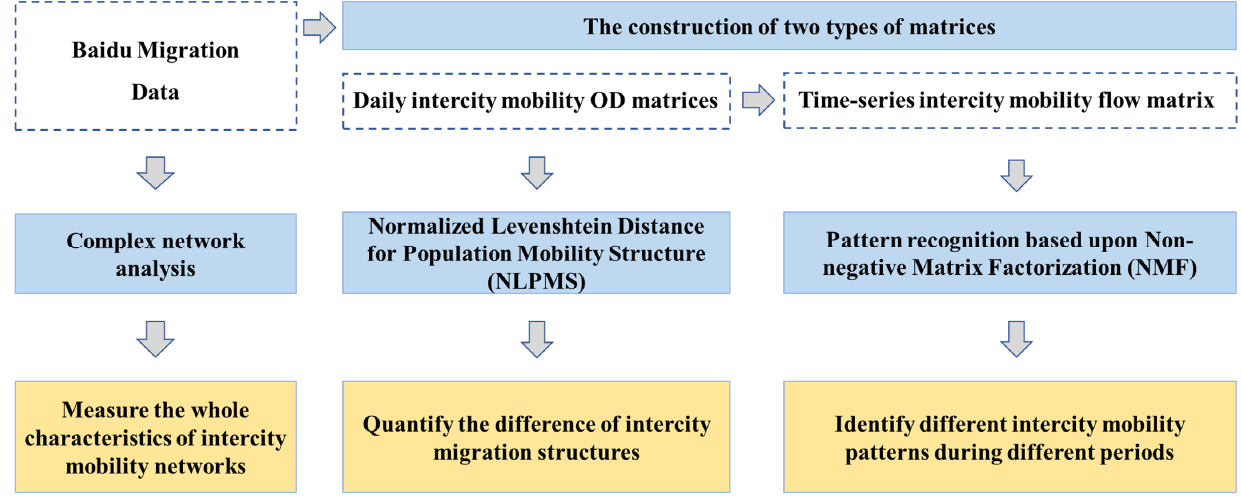
Figure 2. The proposed workflow for characterizing intercity mobility patterns.